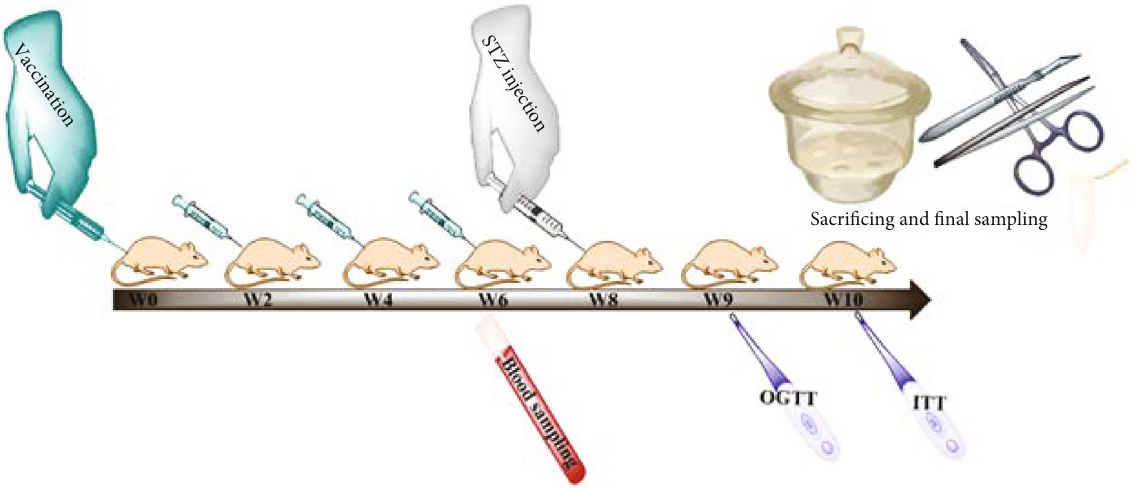
Figure 1: Schematic of animal interventions during the